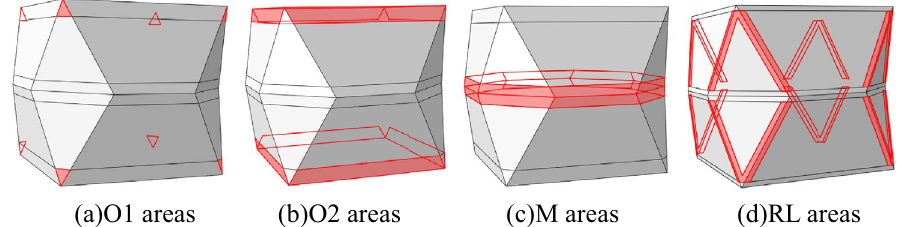
Figure 9. Model partition schematic.